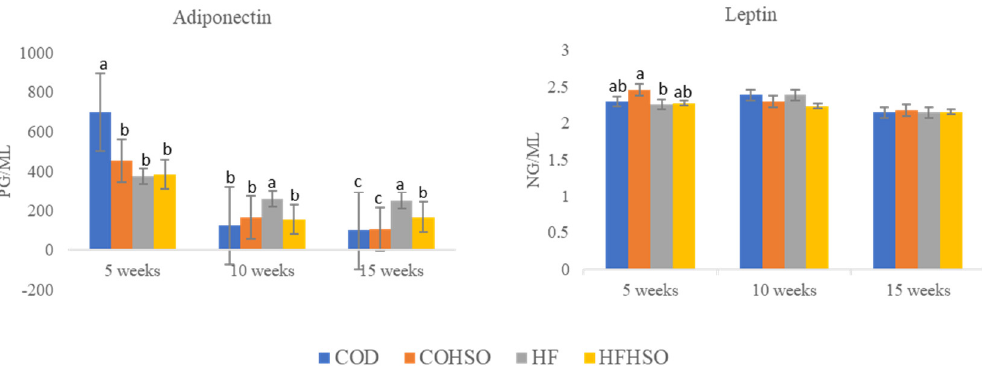
Figure 4. Adiponectine and leptin for rats. Significant p ≤ 0.05, a: the most significant result. All groups were compared with each other within the same week. The same bar with different superscript letters is significantly different among groups within the same week ( p < 0.05). COD: control